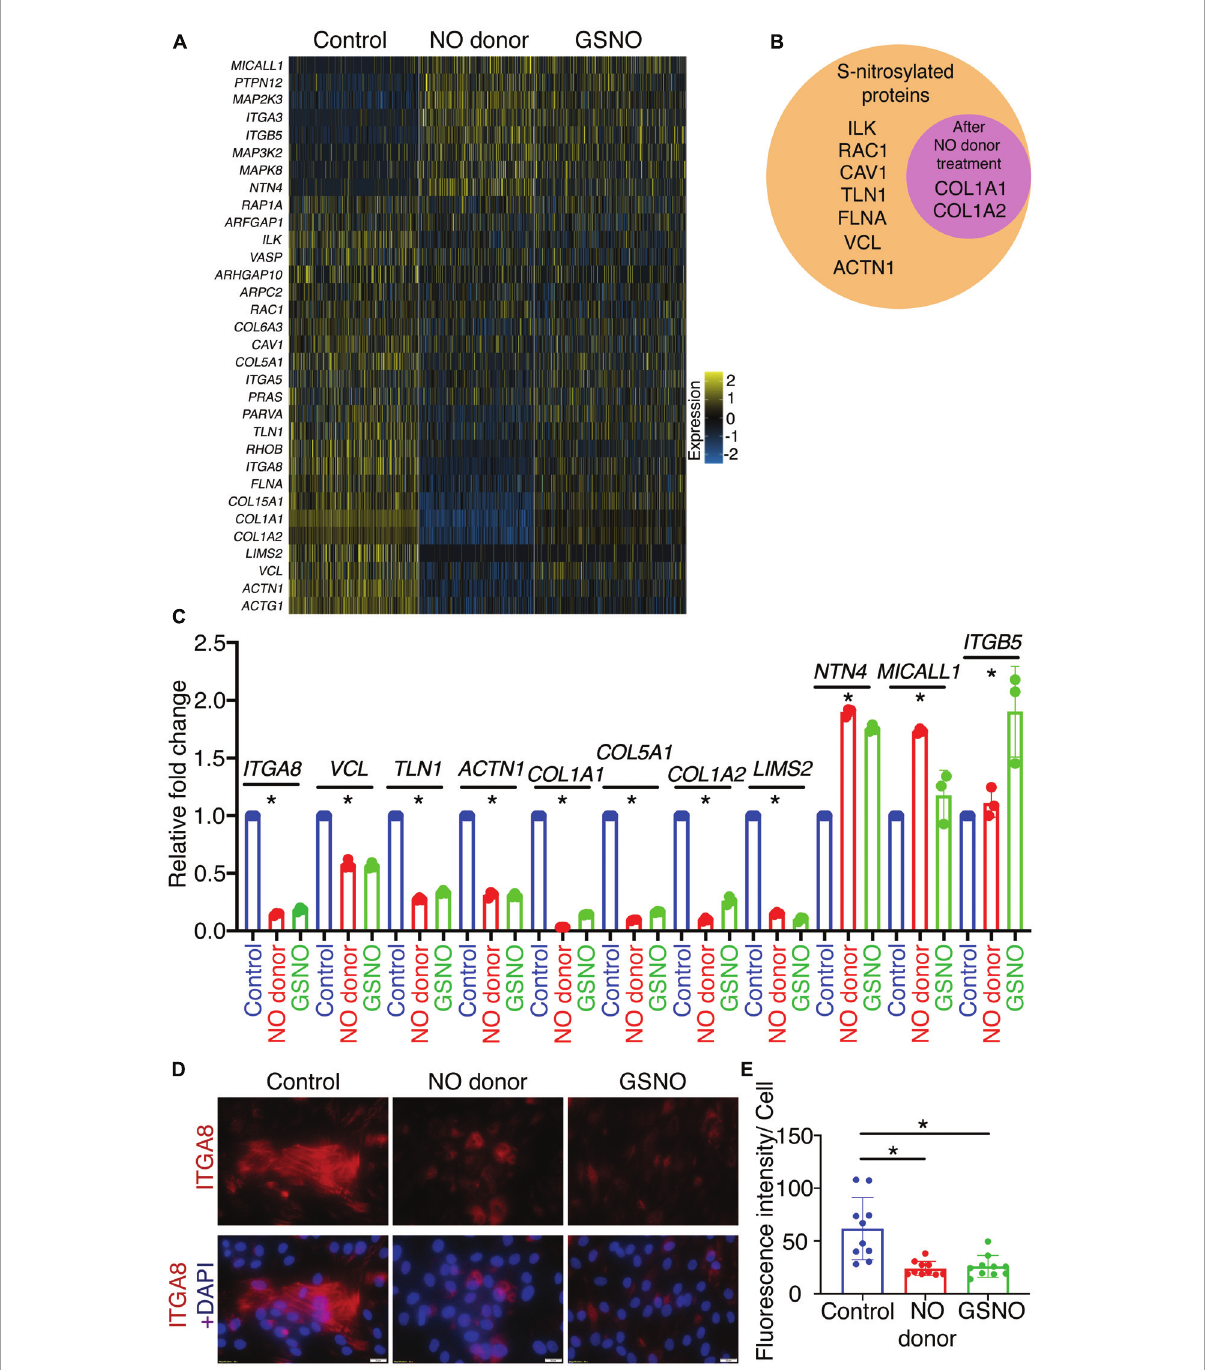
FIGURE2 Identification and validation of differentially expressed genes involved in integrin signaling pathway in porcine aortic valve interstitial cells (pAVICs) exposed to nitric oxide (NO) donor or S-nitrosoglutathione (GSNO). (A) Heatmap represents Z -scored expression of 32 differentially expressed genes involved in the integrin signaling pathway in individual cells from control, NO donor, and GSNO treated pAVICs. (B) Diagram representing the protein product of differentially regulated integrin pathway genes, which were S-nitrosylated in valve interstitial cells (VICs). The circle inside represents S-nitrosylated proteins enriched after NO donor treatment. (C) Transcriptional expression of 11 representative genes from the integrin signaling pathway was estimated in control, NO donor, and GSNO-treated pAVICs by quantitative real time polymerase chain reaction (RT-PCR). (D) Immunofluorescence images represent the decreased expression of ITGA8 (red) with NO donor and GSNO when compared to untreated control pAVICs, co-stained with nuclear DAPI (blue). Scale bar: 20 µ m. (E) The graph shows the quantification of fluorescence intensity of ITGA8 expression in control, NO donor, and GSNO treated pAVICs normalized to the number of cells. *Indicates p ≤